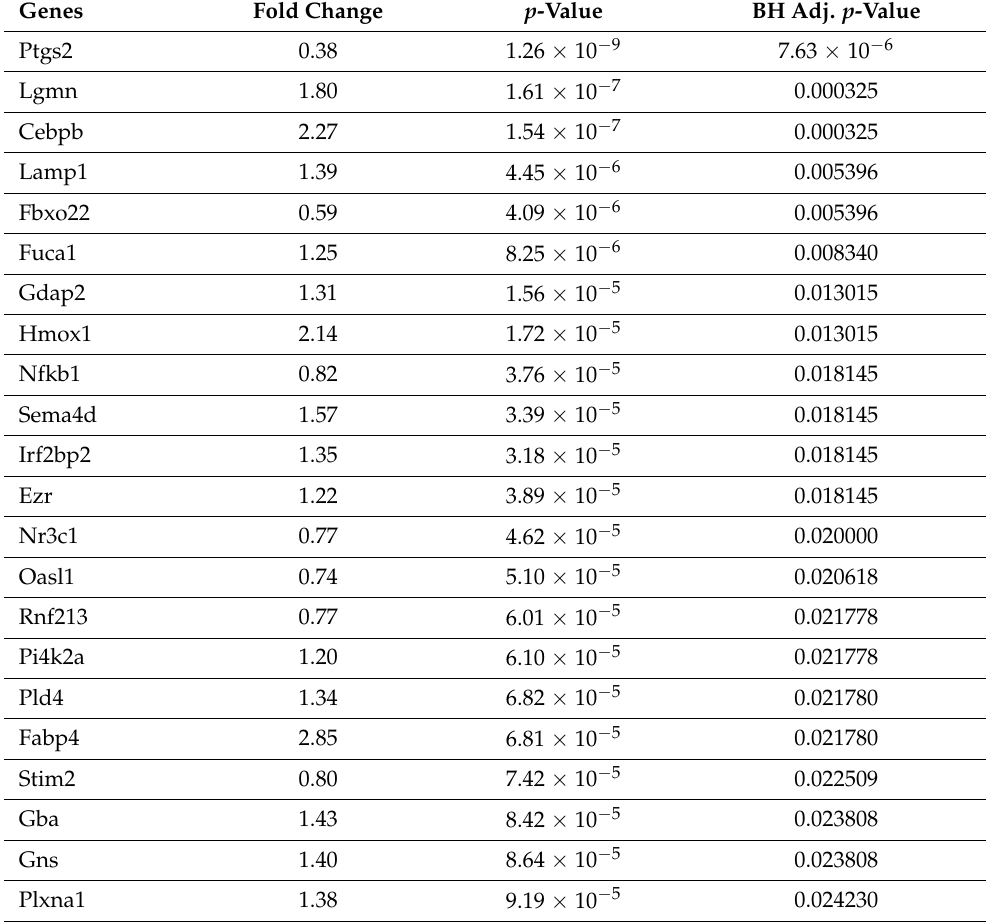
Table 1. Gene names for the differentially expressed proteins (adjusted p -value < 0.05 and fold change > 1.2) ranked by adjusted p -value. BH,